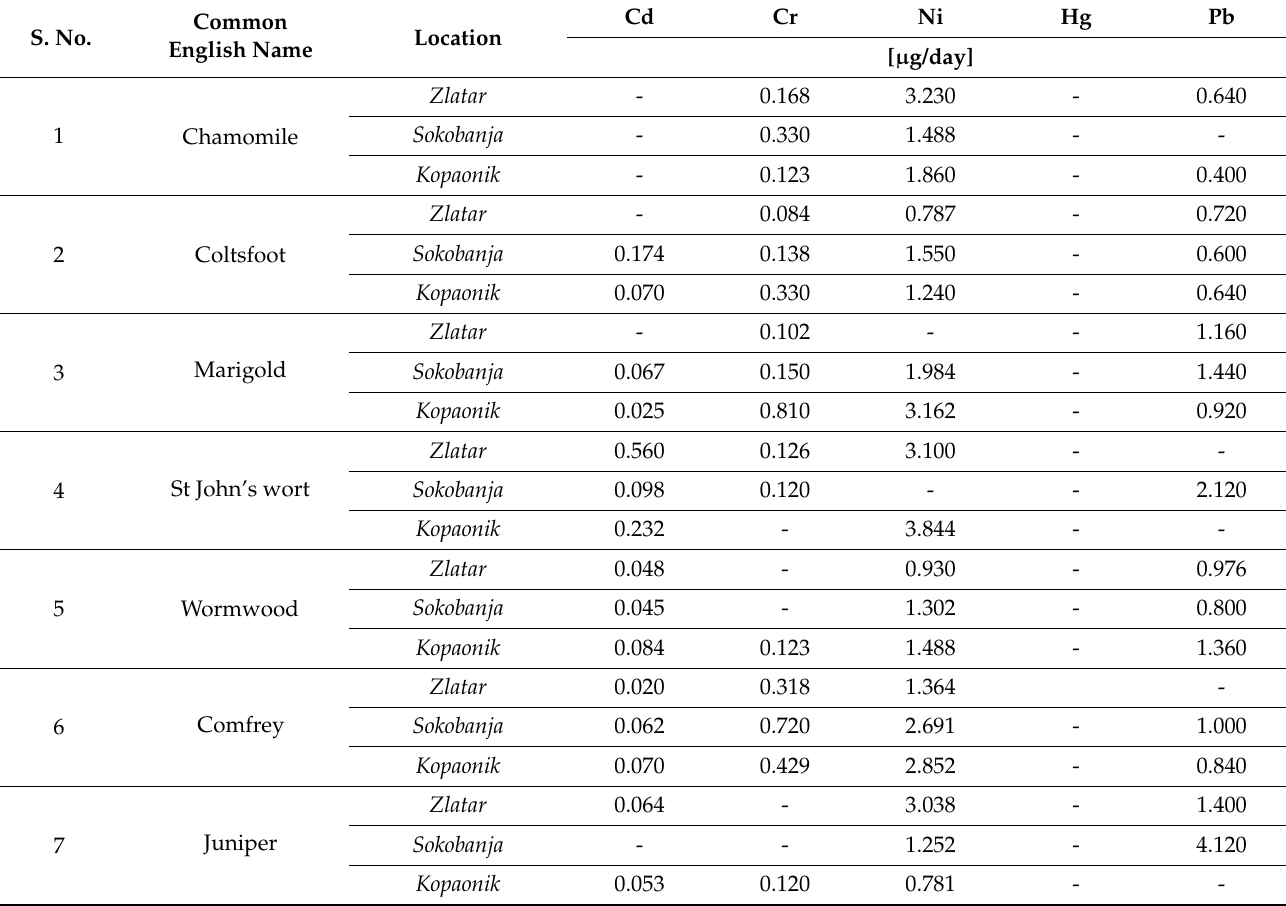
Table 4. The daily intake ( µ g/day) of Cd, Cr, Ni and Pb due to ingestion of the 200 mL herbal infusion made from the investigated medicinal